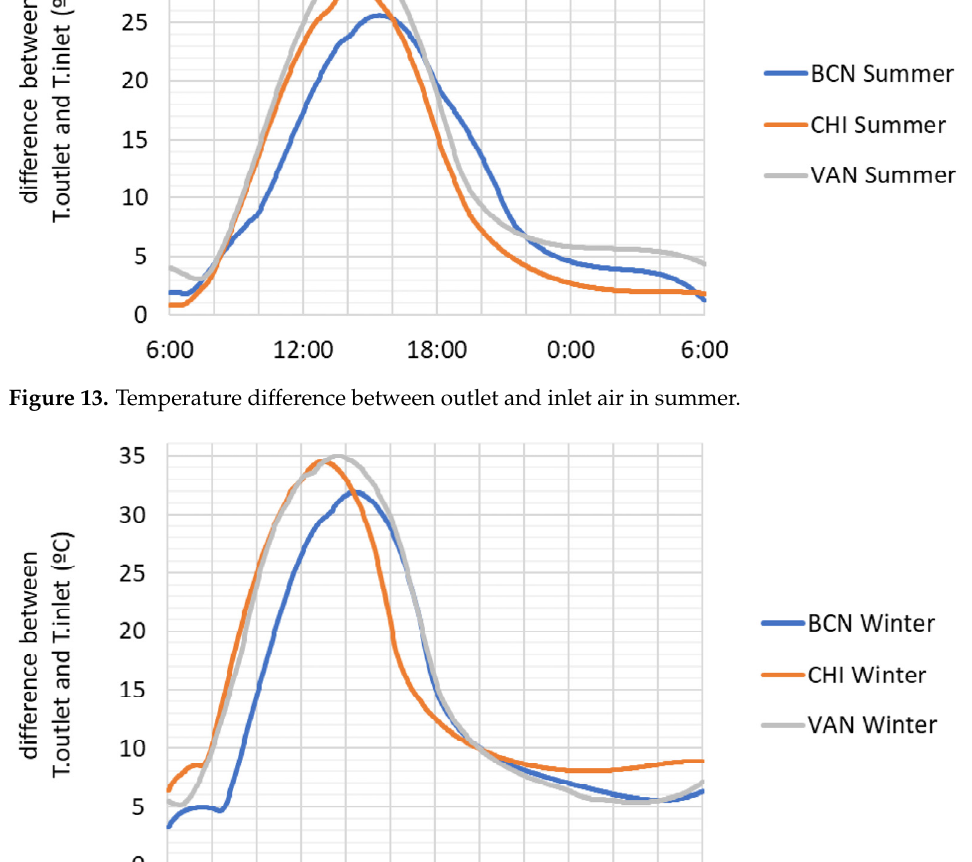
Table 8. Maximum, average, minimum, and fluctuation of the difference of temperatures between inlet and outlet air.